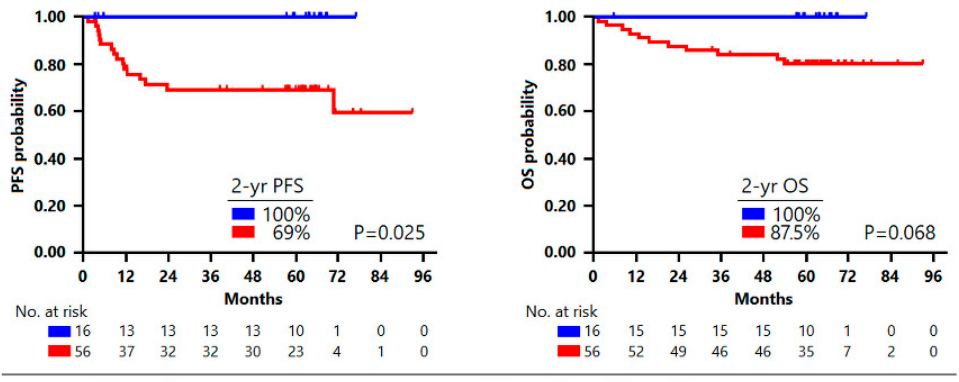
Figure 1. Survival analysis according to mutation profiling. Kaplan–Meier curves estimate progression-free survival ( left ) and overall survival ( right ) by mutational profile. In blue: patients with favorable profile; in red: patients with non-favorable profile.